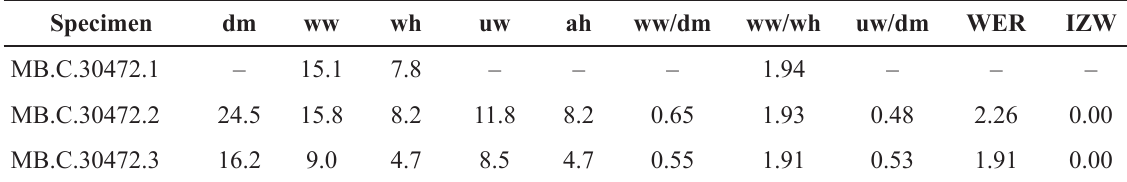
Table 10. Conch dimensions (in mm) and ratios of Vestinautilus inflexus sp.